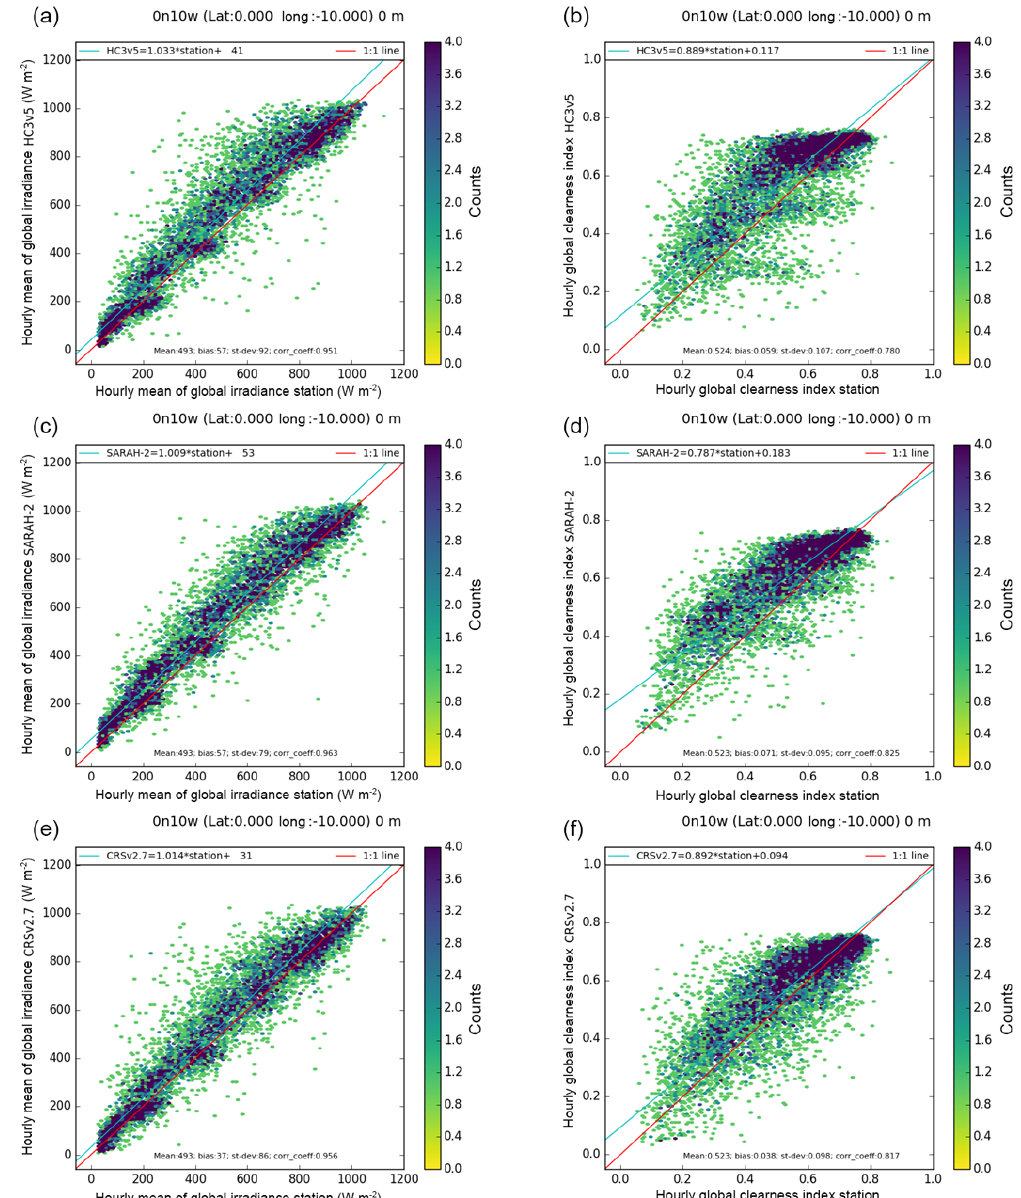
Figure B1. The 2-D histograms of PIRATA measurements (horizontal axis) and data sets (vertical axis) at 0 ◦ N, 10 ◦ W for E and KT. HC3v5: (a) and (b) ; SARAH-2: (c) and (d) ; CRS: (e) and (f) . Ideally, the dots should lie along the red line (1:1 line). The blue line is the affine function fitted over the points and should ideally overlay the red